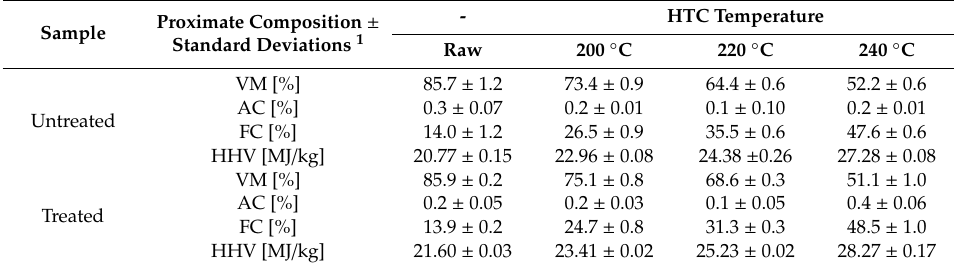
Dry basis proximate composition and energy value of hydrochar from treated